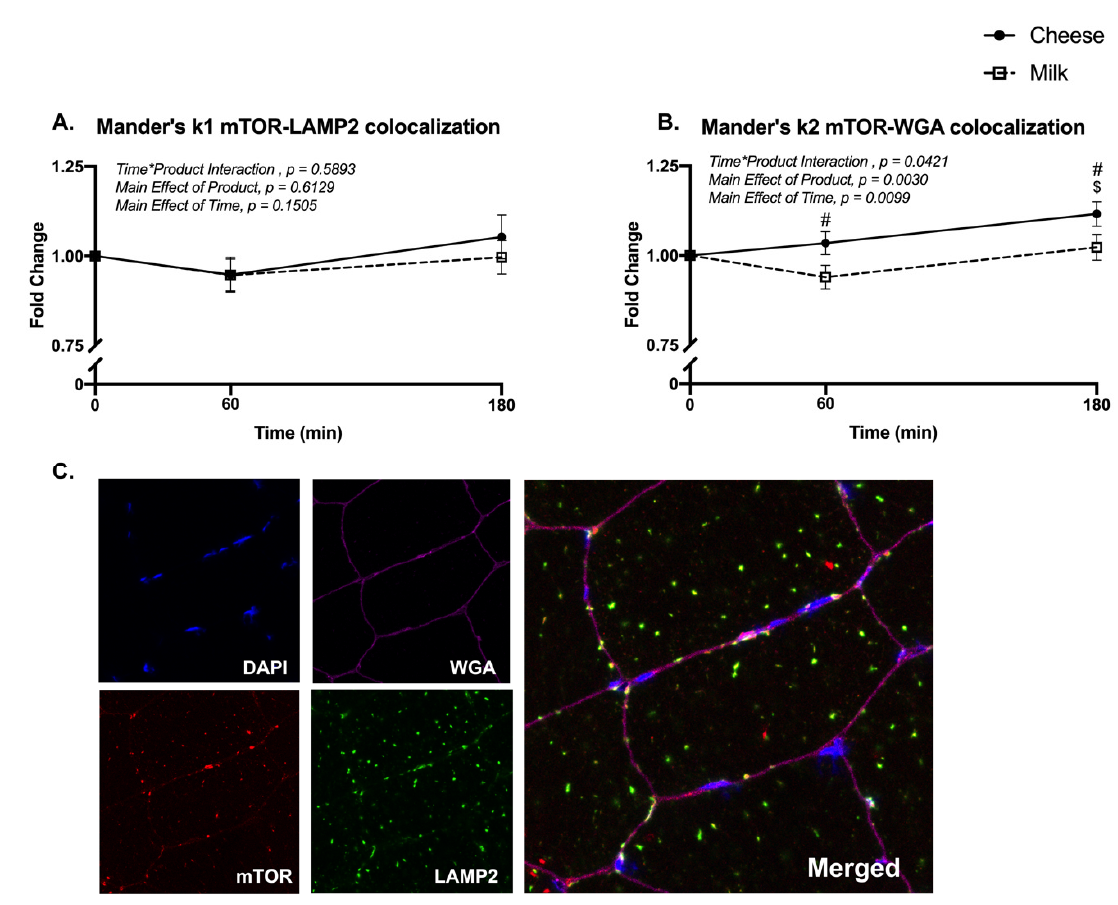
Figure 5. Skeletal muscle mTOR colocalization using immunohistochemistry. Panel ( A ) represents Mander’s k1 mTOR- LAMP2 colocalization and ( B ) Mander’s k2 mTOR-WGA colocalization at baseline (0 min) and at 60 and 180 min following the ingestion of either cheese (solid line) or milk (dotted line) in men and women ( n = 24). Panel ( C ) are representative images using immunohistochemistry. Different from baseline (0 min) for cheese ( $ ), p < 0.05. # , Different between groups at the specific time point, p < 0.05.